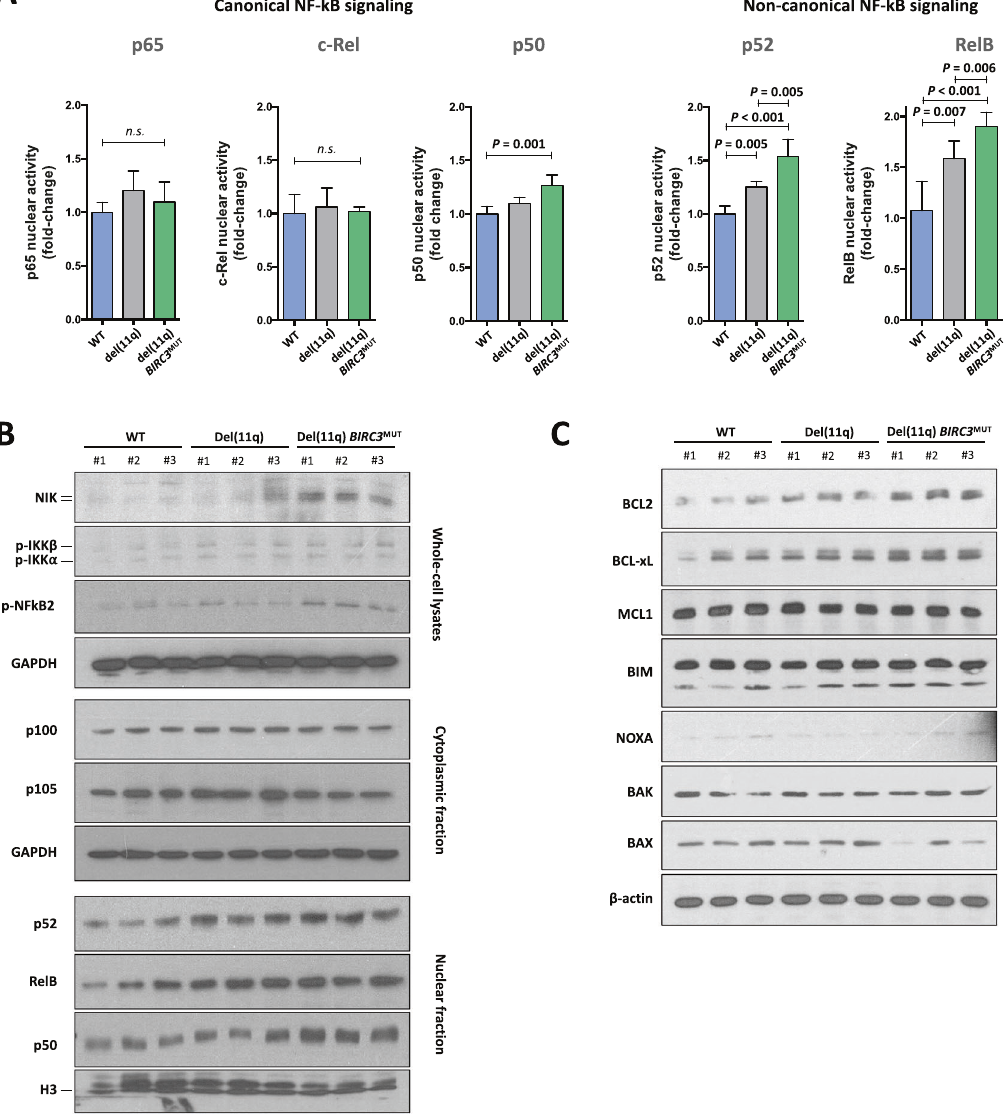
Fig. 2 Evaluation of canonical and non-canonical NF- κ B activity in del(11q)/ BIRC3 -de fi cient CRISPR/Cas9-engineered CLL cells. A ELISA measurement of relative NF- κ B family transcription factor DNA-binding activity in nuclear extracts from HG3-edited clones. Left panel shows DNA-binding activity of NF- κ B transcription factors involved in the canonical signaling (p65, c-Rel, and p50). Right panel displays the DNA- binding activity of non-canonical NF- κ B transcription factors (p52 and RelB). Data are represented as the mean ± SD. B Whole-cell, cytoplasmic and nuclear lysates of HG3-del(11q) clones analyzed by immunoblotting for NIK, p-IKK α / β , p-NF- κ B2, NF- κ B2 (p100/p52), NF- κ B1 (p105/p50), and RelB proteins. GAPDH was used as loading control for whole-cell and cytoplasmic lysates and H3 was used as loading control for nuclear extracts. Relative quanti fi cation for each protein (mean of three clones per condition) is depicted in Supplementary Fig. 3b. C Whole-cell lysates from HG3 WT , HG3-del(11q), and HG3-del(11q) BIRC3 MUT analyzed by immunoblotting for BCL2 family members: BCL2, BCL-xL, MCL1, BIM, NOXA, BAK, and BAX. β -actin was used as loading control. Relative quanti fi cation for each protein (mean of three clones per condition) is detailed in Supplementary Fig.